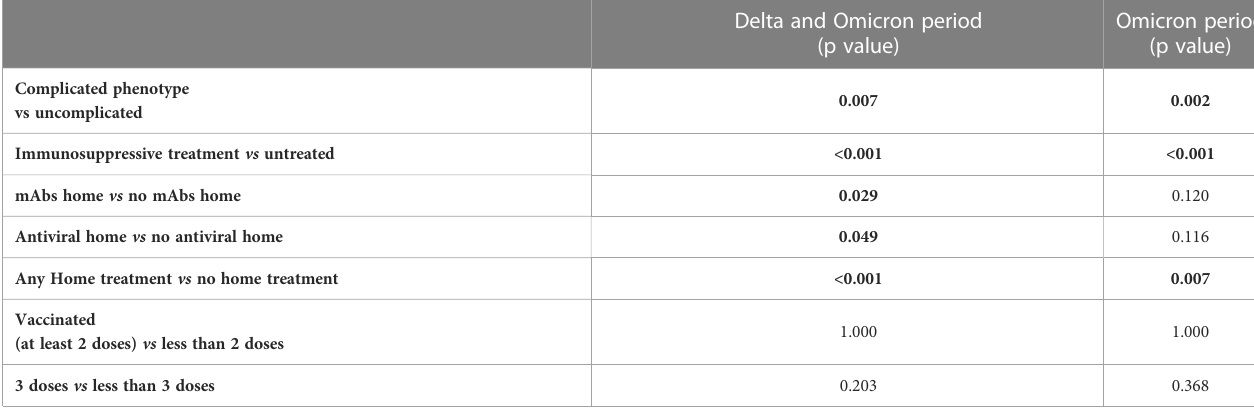
TABLE 3 Chi square/Fisher exact test for hospitalization considering the period of Delta and Omicron wave together and of Omicron wave